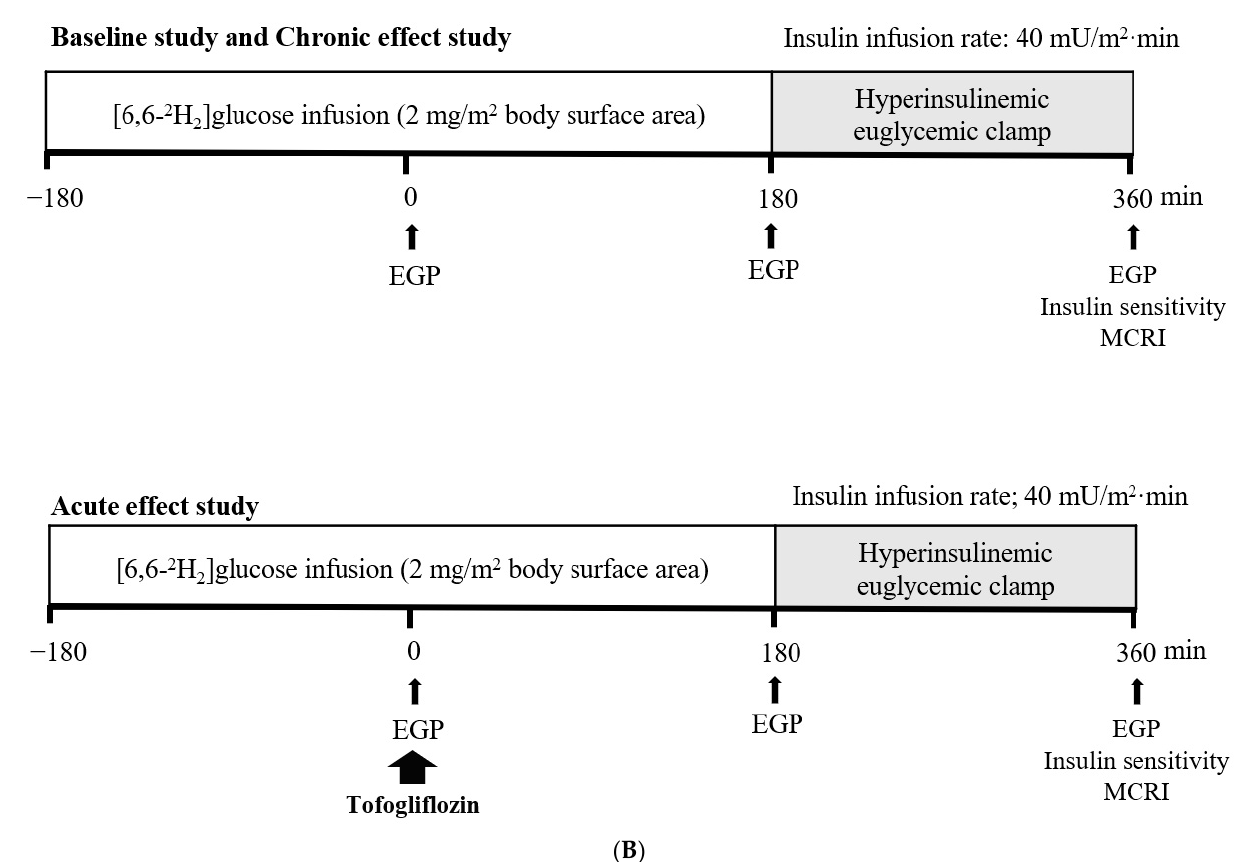
Figure 1. ( A ). Timeline of this study. ( B ) Design of the baseline, acute effect, and chronic effect studies. EGP, endogenous glucose production; MCRI, metabolic clearance rate of insulin.